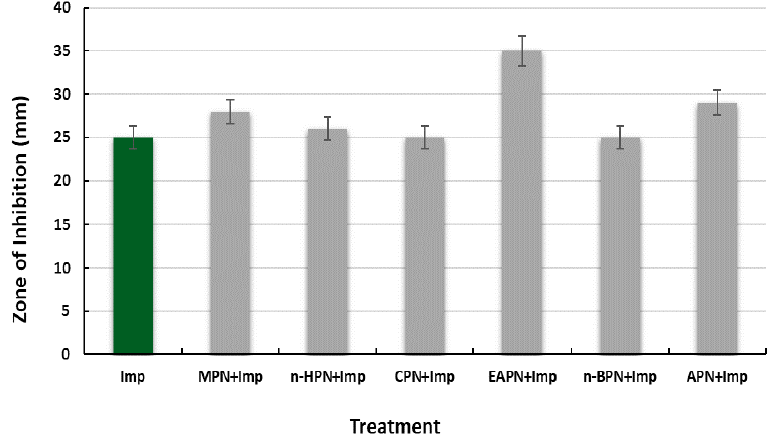
Figure 14. Antibiotic reversal activity of P. nigrum extracts in combination with Imipenem (10 µ g) for S. typhi .